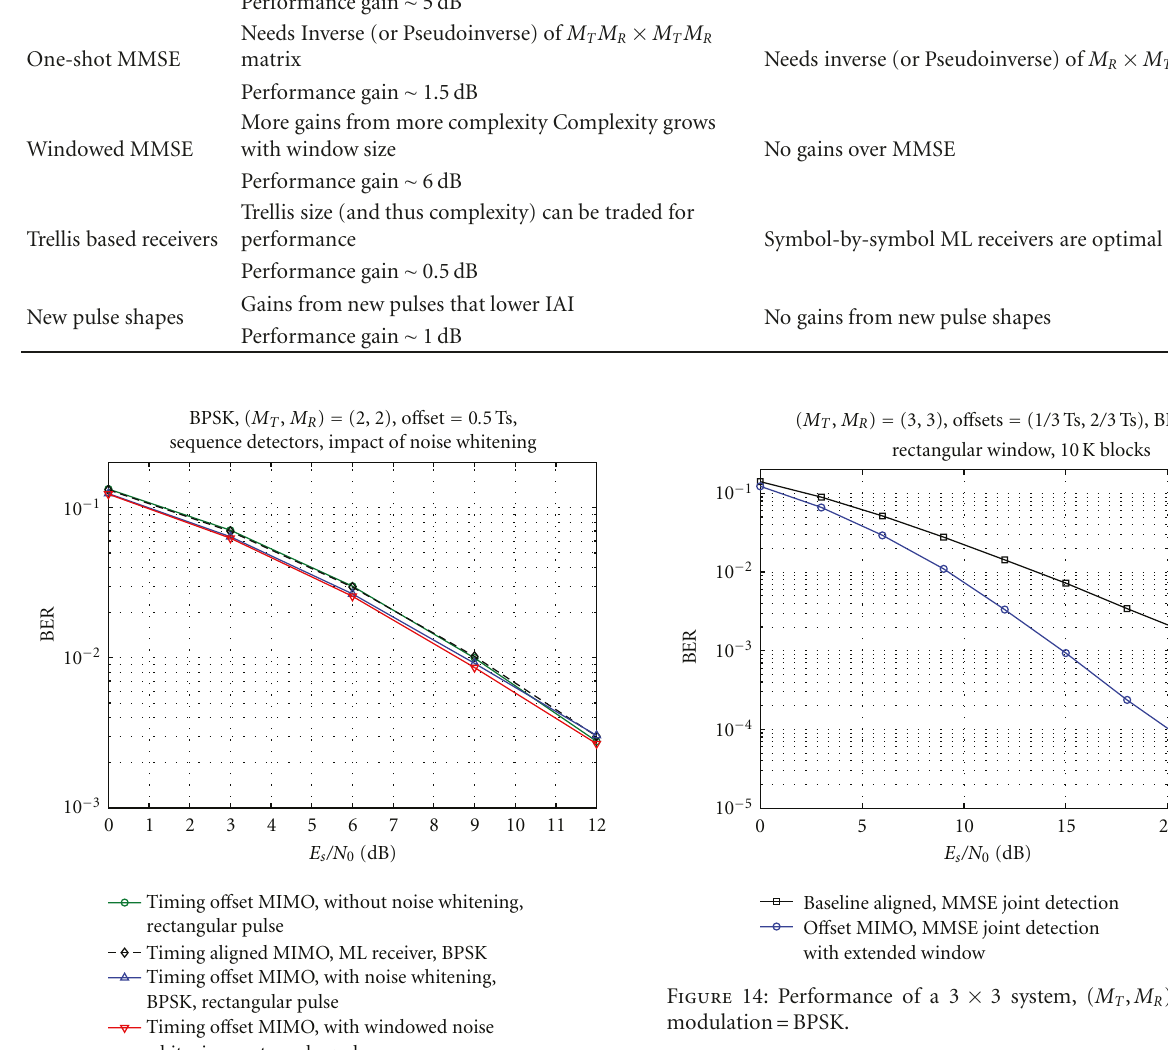
Figure 13: Impact of noise whitening on trellis-based receivers, ( M T , M R ) = (2,2), modulation = BPSK.